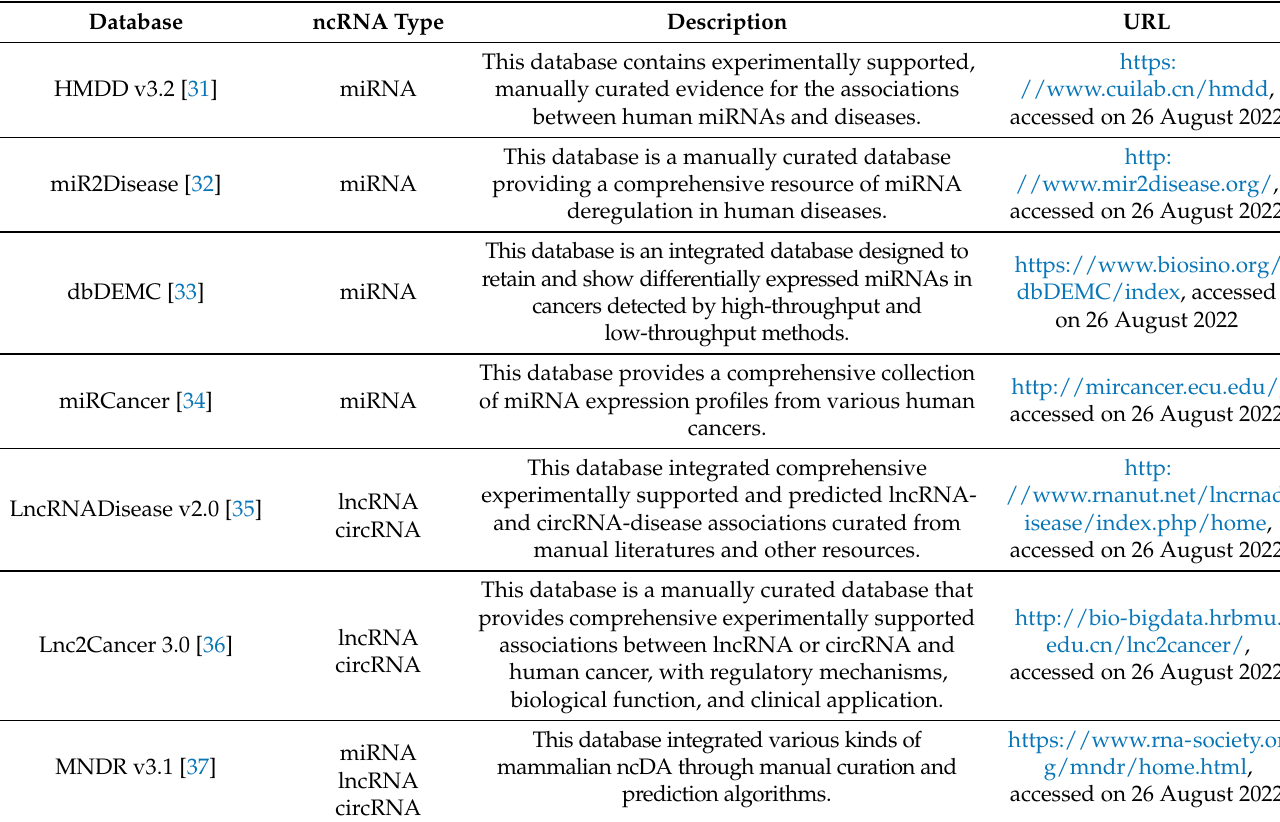
Table 1. Summary of various ncDA